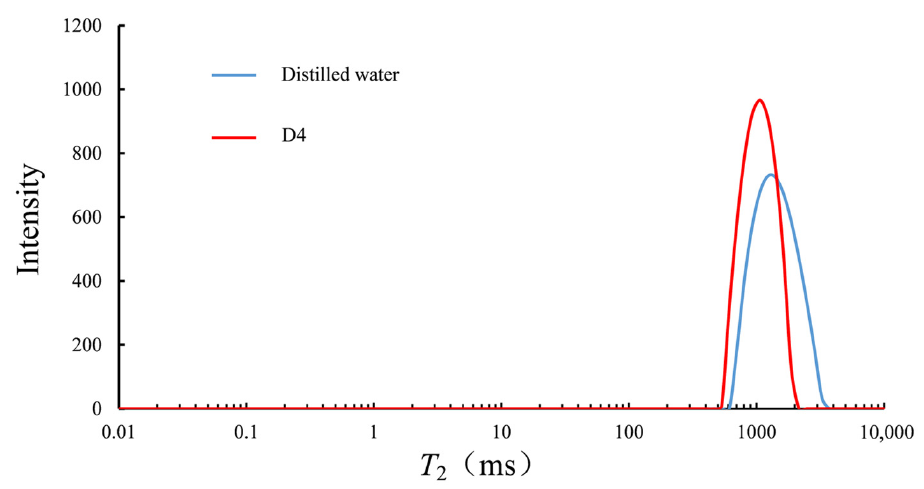
Figure 5. Comparison of T 2 spectrums between distilled water and D4.